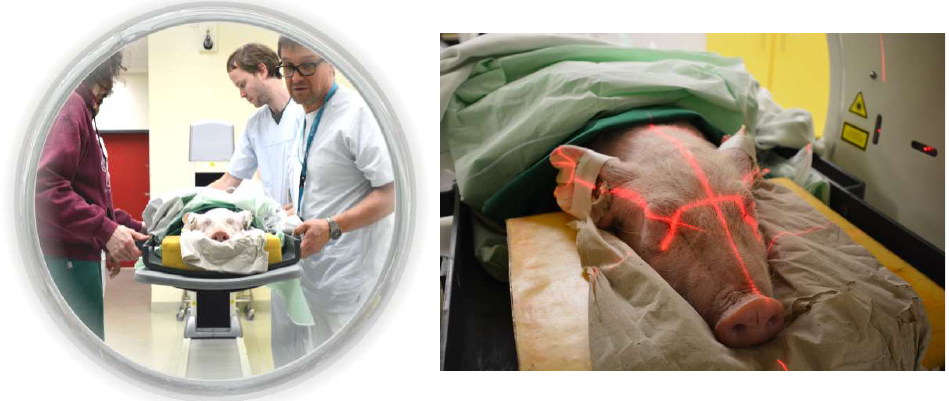
Figure 5. The animals were placed in a plastic trough and a special head rest to guarantee reproducible positioning and avoid the movement of artefacts.